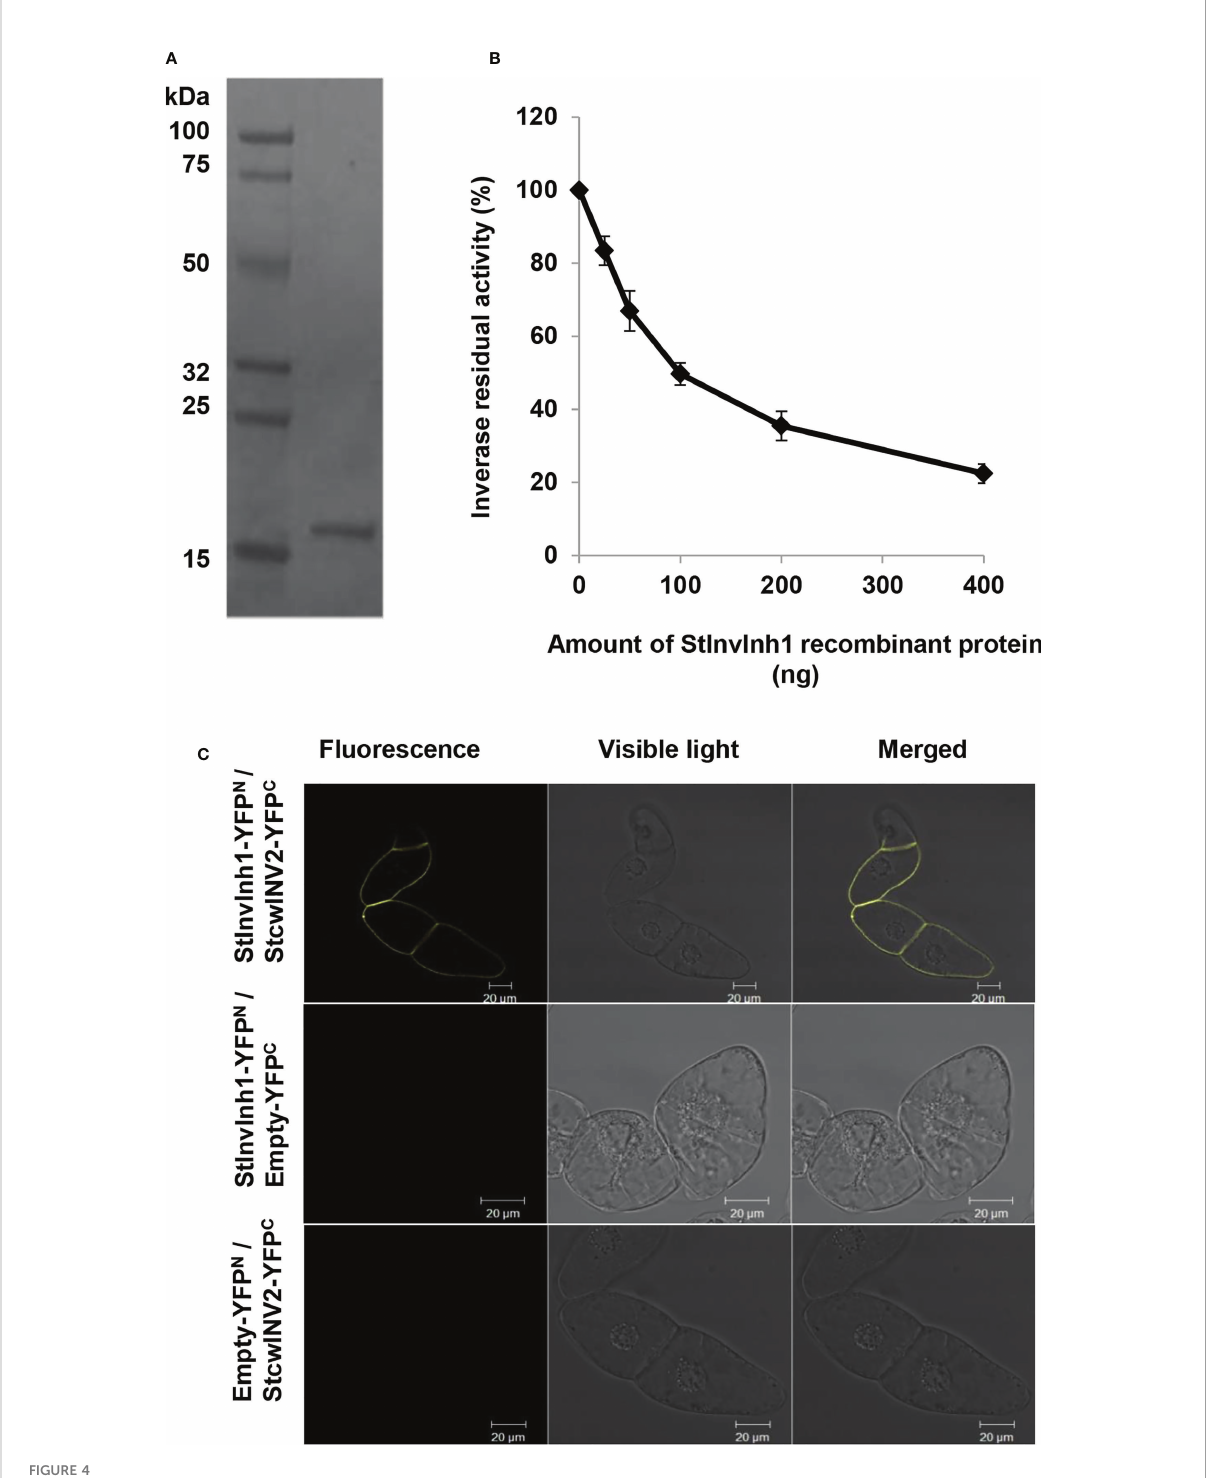
FIGURE 4 Inhibitory functions of StInvInh1. (A) The puri fi ed recombinant StInvInh1 protein; (B) Inhibitory effects of recombinant StInvInh1 protein on CWI activity in potato. Dose-dependent effects of StInvInh1 protein on CWI activity isolated from potato leaves are shown. Residual invertase activity was measured at pH 4.6 and 37°C after 30 min pre-incubation of the recombinant StInvInh1 protein and crude CWI in potato leaves. (C) Interaction of StInvInh1 and StcwINV2 proteins in tobacco BY-2 cells by bimolecular fl uorescence complementation. Tobacco BY-2 cells were transformed by particle bombardment with a set of constructs for StInvInh1-YFP N and StcwINV2-YFP C , StInvInh1-YFP N and empty-YFP C , empty -YFP N and StcwINV2-YFP C ,